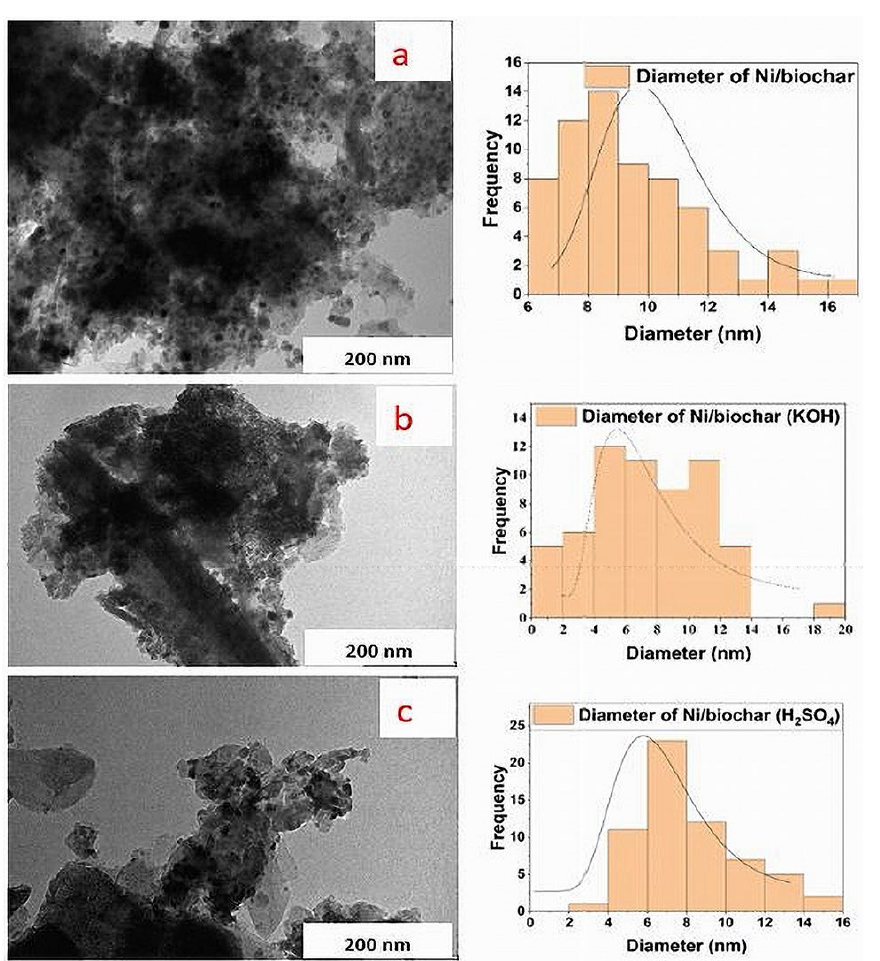
Figure 3. TEM analysis and histograms of the Ni metal nanoparticle sizes of ( a ) Ni/biochar, ( b ) Ni/bi- ochar (KOH), and ( c ) Ni/biochar (H 2 SO 4 ). ( b ) Ni/biochar (KOH), and ( c ) Ni/biochar (H 2 SO 4